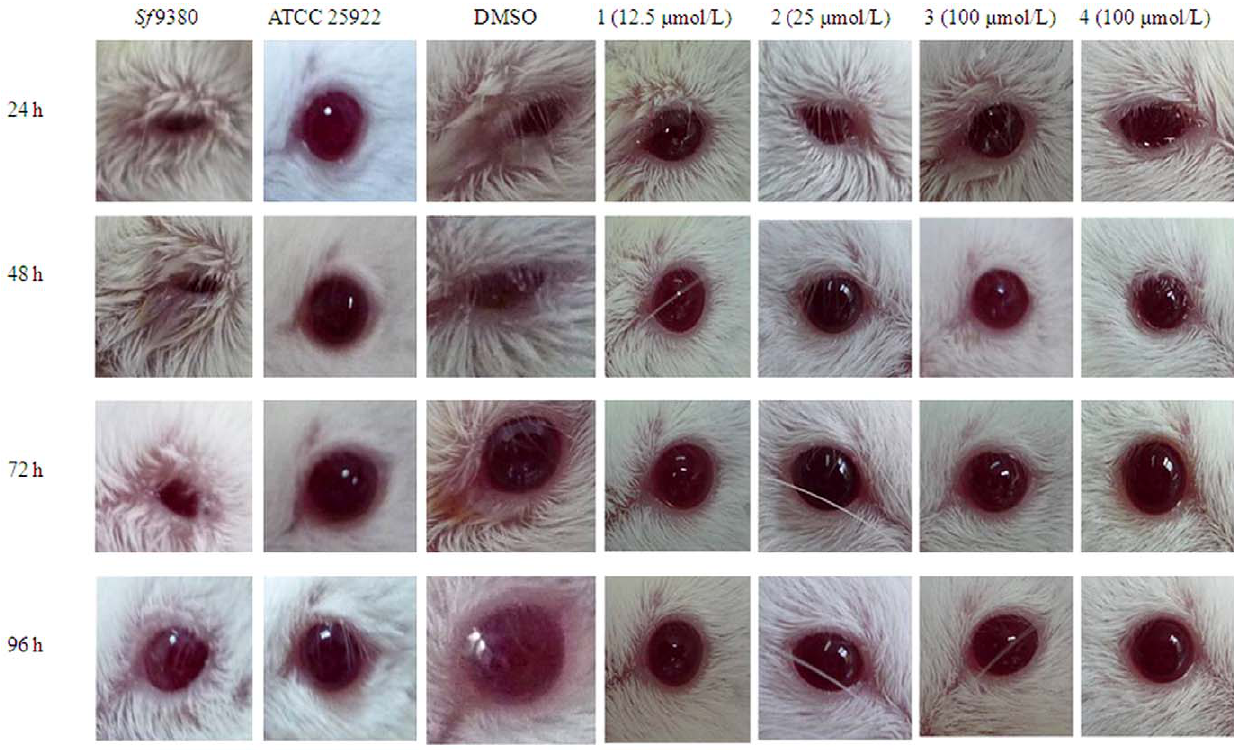
Figure 8. Potential PhoQ inhibitors can reduce the degree of keratoconjunctivitis produced by Shigella in mice. A Mouse Sereny test shows the virulence of S. flexneri with or without potential PhoQ inhibitor treatment. Mice inoculated with 1 6 10 8 CFUs of S. flexneri Sf 9380 show severe keratoconjunctivitis without purulence at 24 hours after infection, which develops to keratoconjunctivitis with purulence after 48 hours and continues for 96 hours. Sf 9380 cultured with a serial dilution of potential PhoQ inhibitors were also inoculated into mouse eyes at 1 6 10 8 CFUs. Mice inoculated with the bacteria pre-treated with potential PhoQ inhibitors 1 (12.5 m mol/L) or potential PhoQ inhibitors 2 (25 m mol/L) display a slight conjunctival inflammation at 24 hours post-infection, and keratoconjunctivitis is resolved by 48 hours. Mice inoculated with the bacteria pre-treated with potential PhoQ inhibitors 3 (100 m mol/L) or potential PhoQ inhibitors 4 (100 m mol/L) display a slight conjunctival inflammation at 24 hours post- infection, and keratoconjunctivitis is resolved by 72 hours. Mice inoculated with the negative control, E. coli ATCC 25922, did not develop conjunctival inflammation. Sf 9380 treated with the same amount of DMSO in which the potential PhoQ inhibitors were dissolved served as a control.